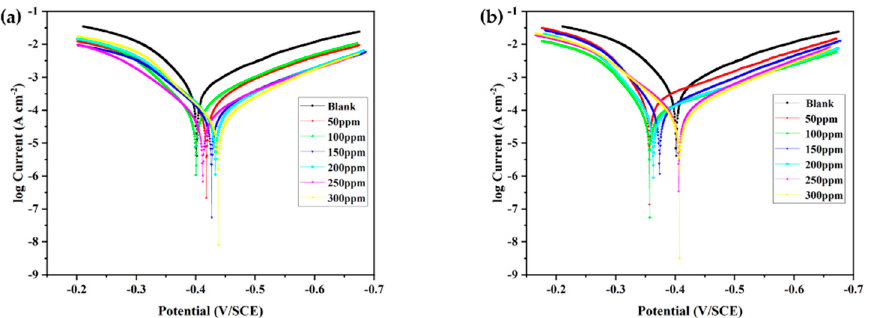
Figure 4. Polarization curves for N80 steel measured in uninhibited 1.0 M HCl and with different concentrations of inhibitor: ( a ) MPO and ( b ) MPPO. Table 3. Electrochemical parameters obtained from polarization curves for N80 steel containing different concentrations of MPO and